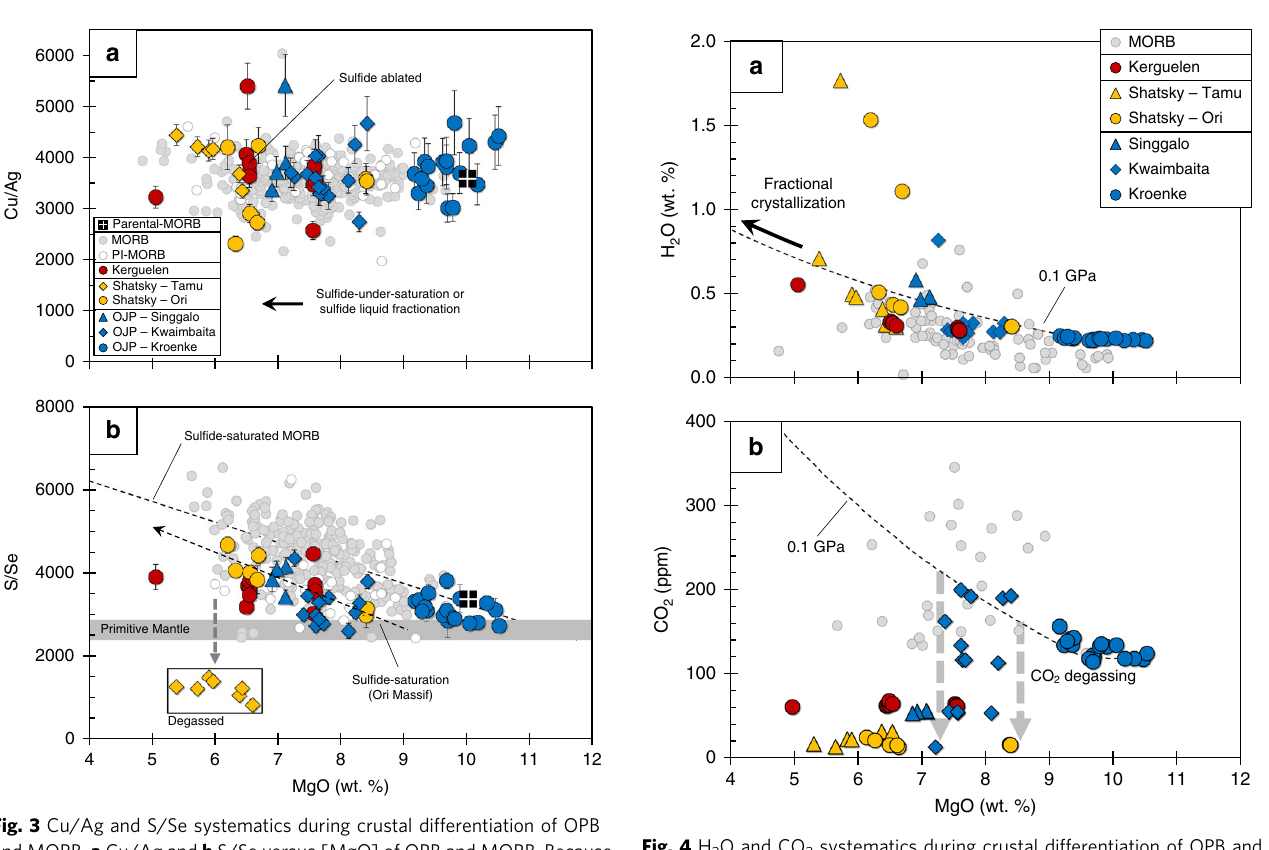
Fig. 4 H 2 O and CO 2 systematics during crustal differentiation of OPB and MORB. a H 2 O and b CO 2 versus [MgO] for OPB and MORB. Because S can strongly partition into a co-existing H 2 O − CO 2 vapor phase (e.g. ref. 5 ), it is